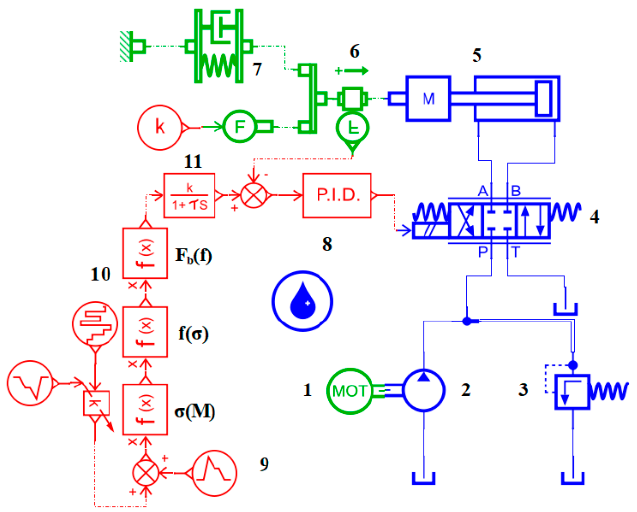
Figure 4. Hydraulic schematic diagram of AMESim air-borne bolting rig propulsion system. 1. Asynchronous motor; 2. Hydraulic pump; 3. Safety valve; 4. Three-position four-way electro-hydraulic proportional directional valve; 5. Hydraulic cylinder with mass; 6. Pressure sensor; 7. Spring damping system; 8. PID parameter controller; 9. Load torque signal; 10. Stochastic noise; 11. Low-pass filter. Table 2. Parameter settings of the main components of the propulsion system model.